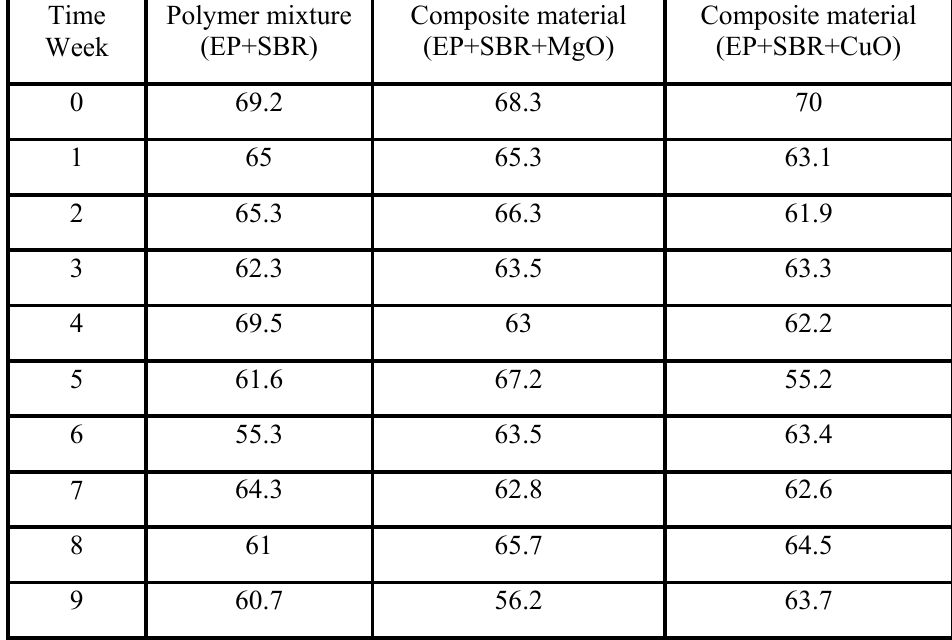
Fig. 2: Variation of hardness with time of immersion for samples. Table 4: The value of hardness shore